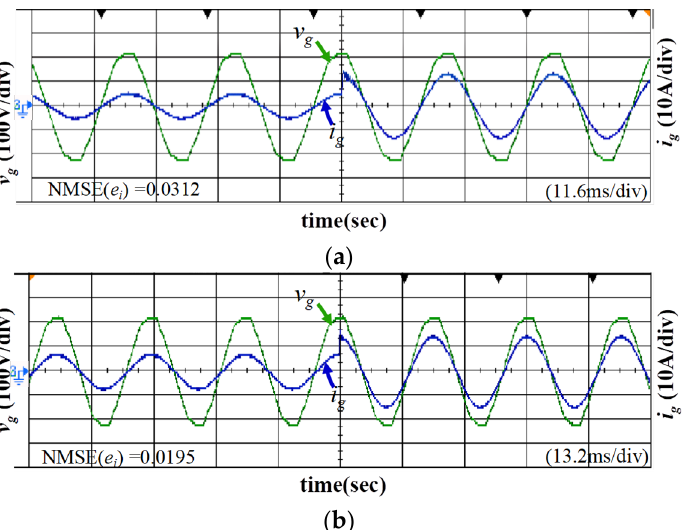
Figure 8. Experimental voltage and current response of grid-connected inverter under grid-connected power variations from 0.5 kW to 1 kW: ( a ) GISMC; ( b ) DRFNNISMC.